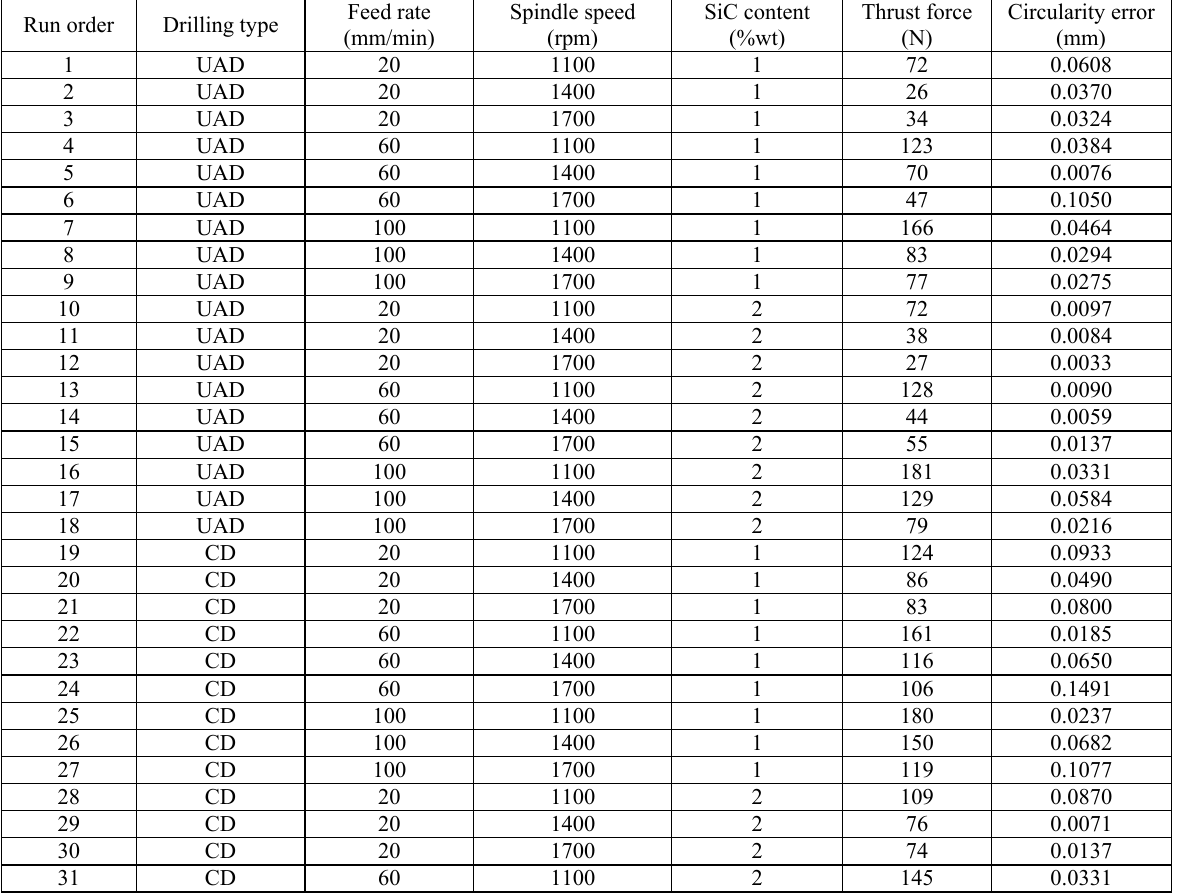
Figure 20. VMM images of holes’ end surface in CD at spindle speeds of: a) 1100 rpm, and b) 1700 rpm. Table 5 Summary of the measured thrust force and circularity error in CD and